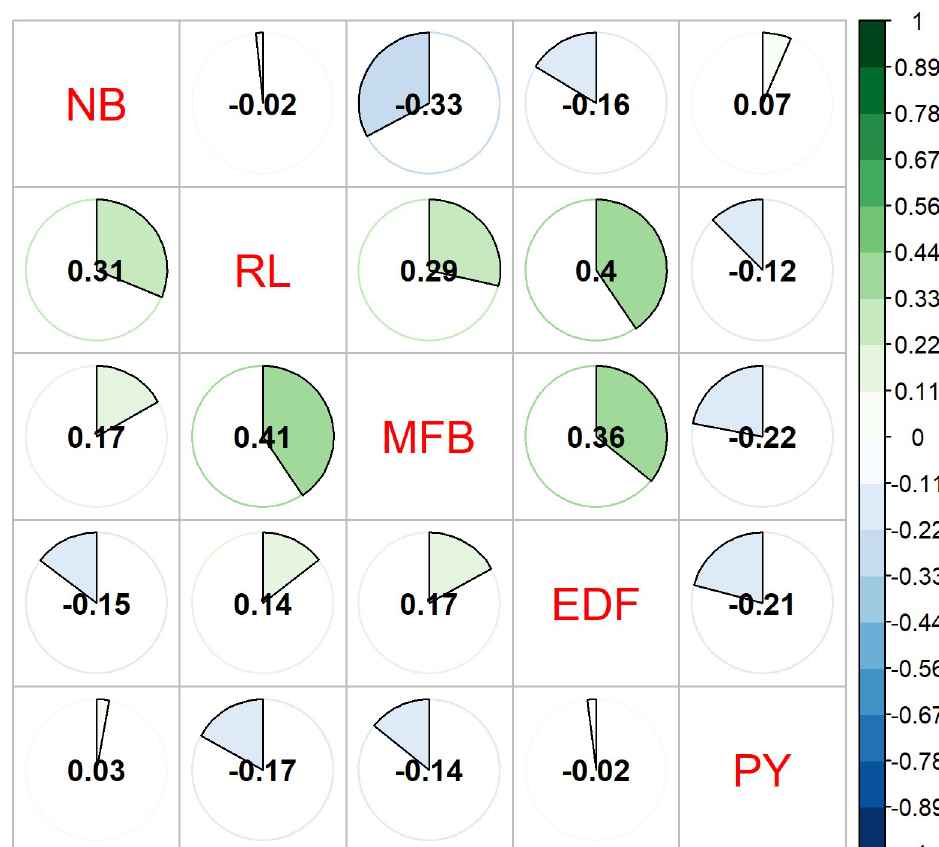
Fig 2. Genetic and phenotypic correlation. Genetic (upper diagonal) and phenotypic (lower diagonal) correlation between the traits RL (Rachis Length), EDF (Equatorial Fruit Diameter), MFB (Fruit Mass per Bunch), NB (Bunch Number) and PY (Pulp yield).